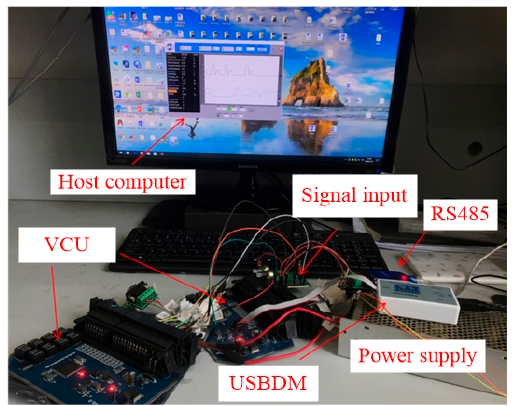
Figure 12. The experimental verification test platform.